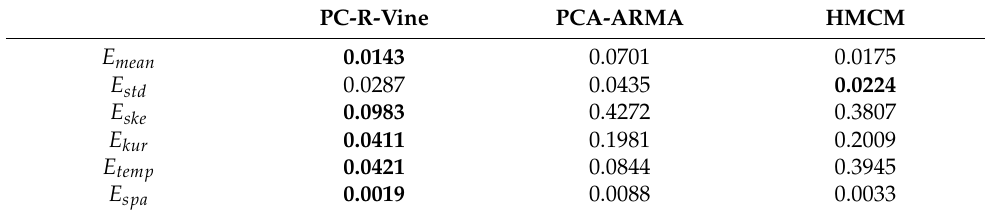
Table 1. Each model’s evaluation